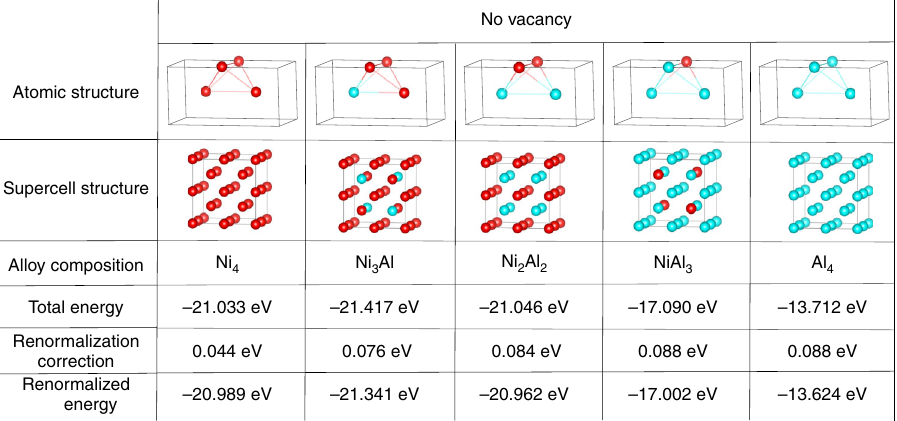
Fig. 3 No vacancy clusters, and their energies in the cluster expansion theory (bcc lattice). Tetrahedral clusters formed by lattice points of two bcc cubic unit cells with all the possible non equivalent combinations of Ni (red sphere) and Al (blue sphere), without vacancies. The second row shows the corresponding 2 × 2 × 2 supercells for the total energy calculation. The total energies per one tetragonal cluster, calculated by ab initio DFT, renormalization corrections at T = 1300 K and the renormalized energies are shown below each structure, respectively